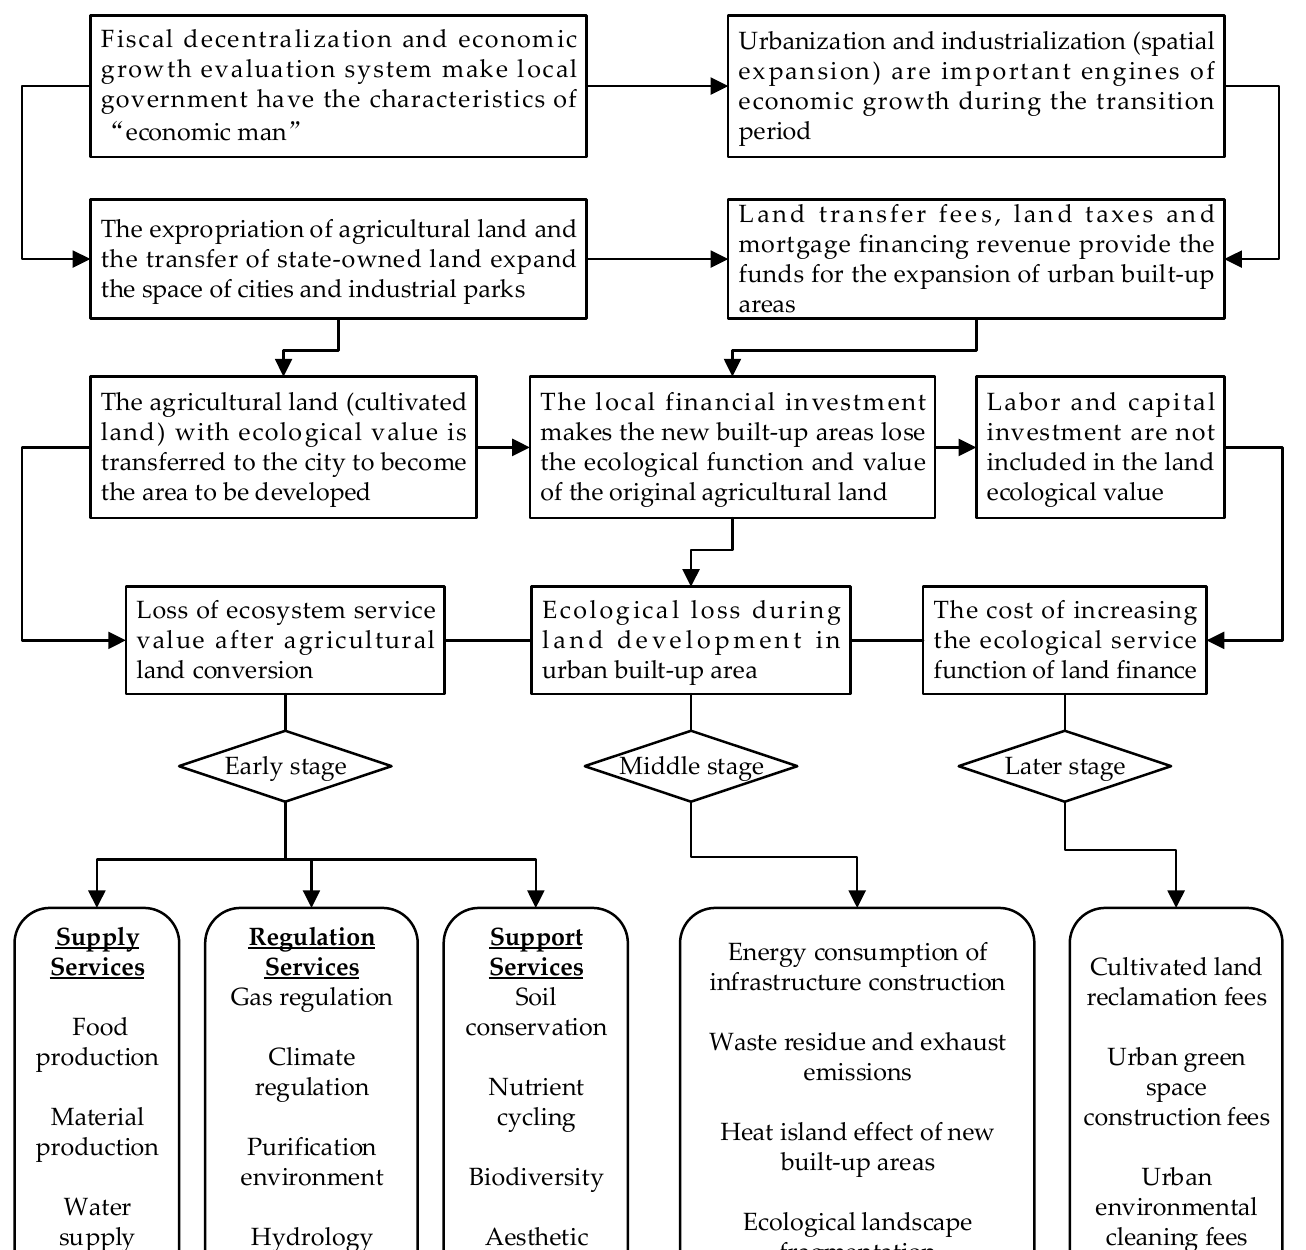
Figure 2. The formation mechanism framework of land fiscal ecological cost.